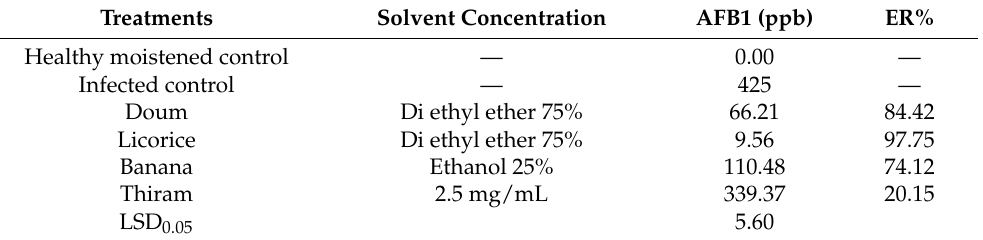
Table 4. Effect of plant extracts on AFB1 production in stored inoculated maize grains with A. flavus . Treatments Solvent Concentration Healthy moistened